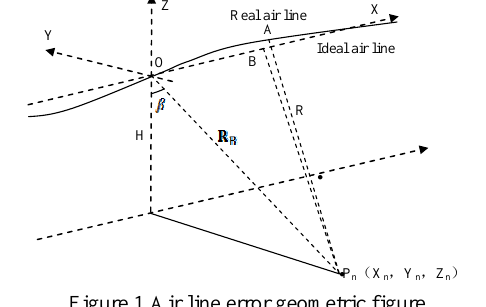
Figure 1 Air line error geometric